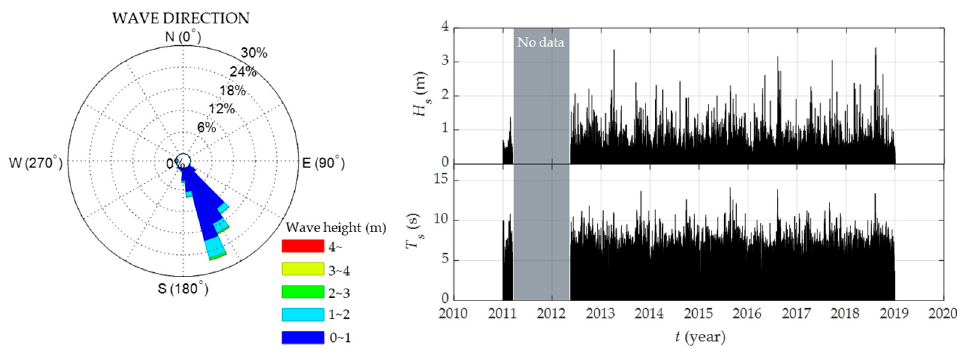
Figure 2. Wave direction, wave height ( H S ), and wave periods ( T S ) measured at Ishinomaki Station (NOWPHAS) 8 km offshore from the Nobiru Coast.